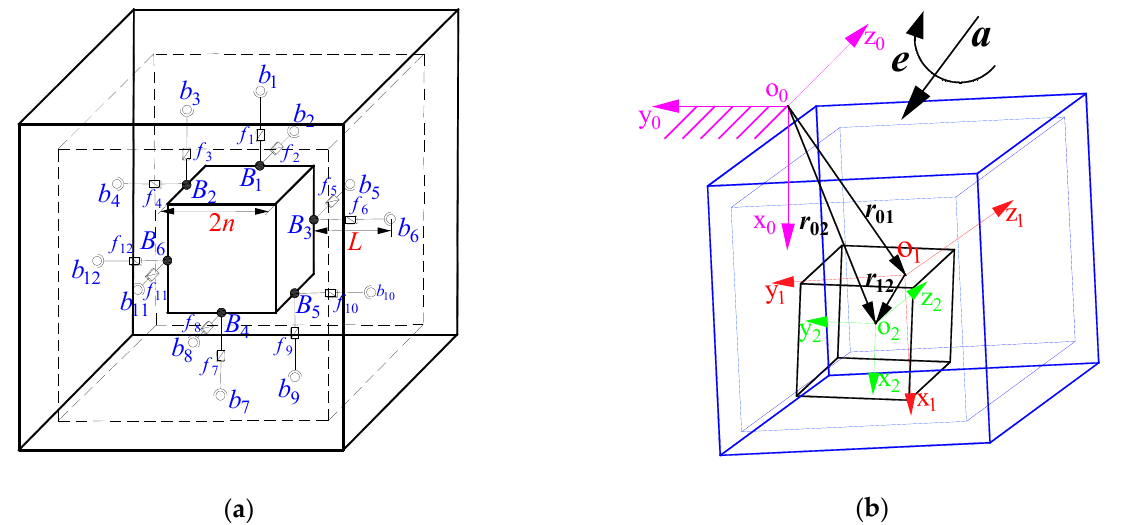
Figure 4. Principle model and coordinate system: ( a ) principle model of the six-axis accelerometer; ( b ) Coordinate relationships between inertial mass, pedestal and ground.